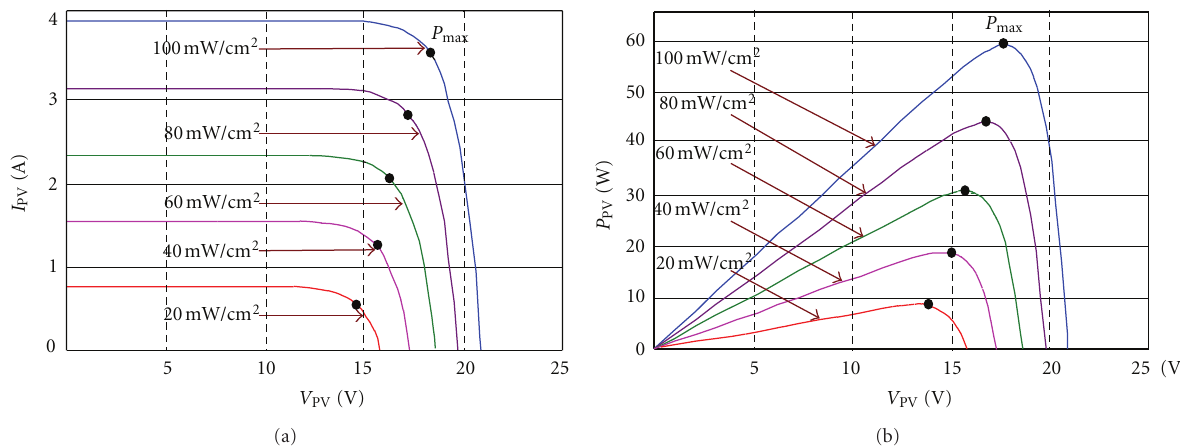
Figure 5: PV arrays with di ff erent insolations: (a) V-I curves, and (b) output power and output voltage curves.